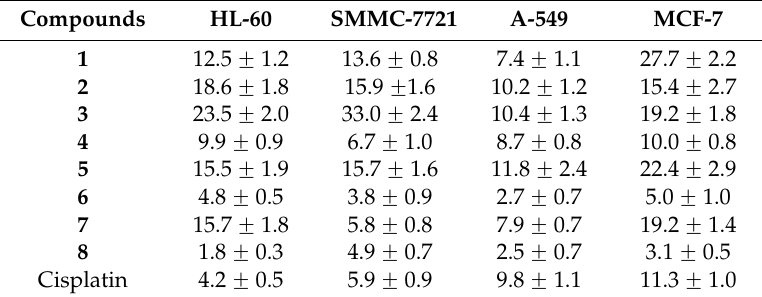
Table 2. Cytotoxic activities of compounds 1 – 8 isolated from C. kiangsiense (IC 50 in µ